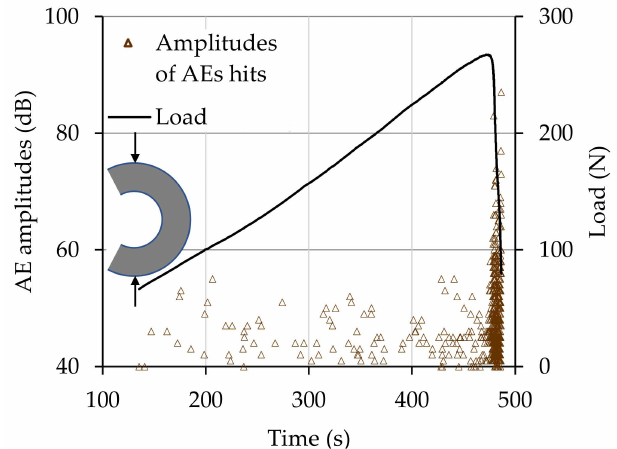
Figure 12. Time evolution of the amplitudes of the AEs together with that of the load applied.